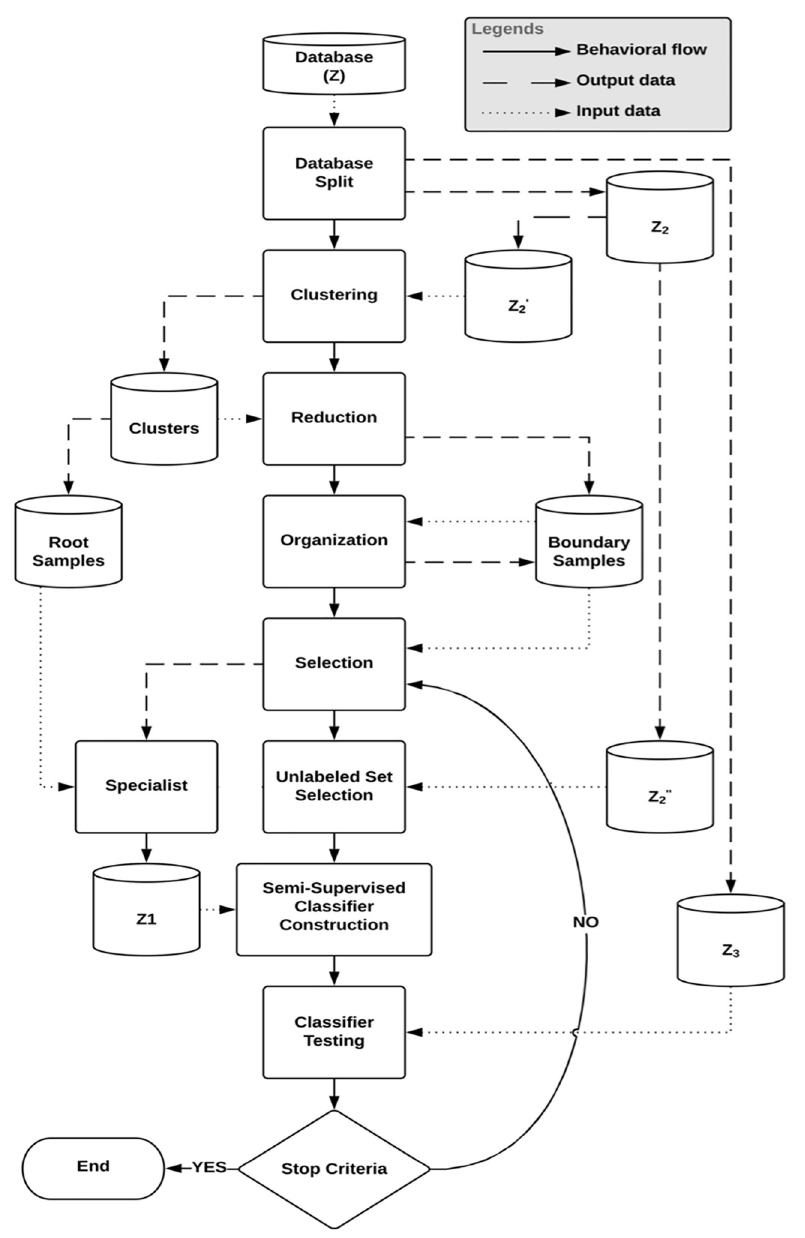
Fig 3. General flowchart of the proposed